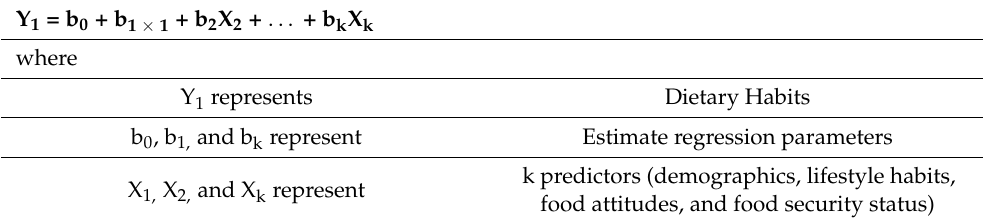
Table 1. Model for regression